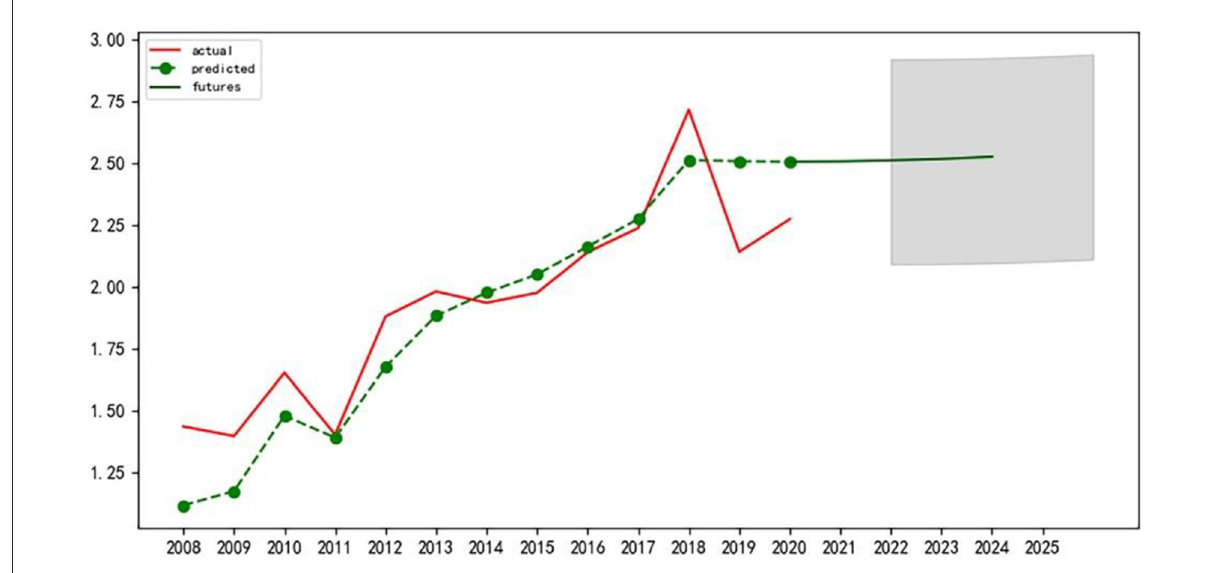
FIGURE2 Prediction of variable eigenvalues of sustainable development level of APSC in Jilin Province.